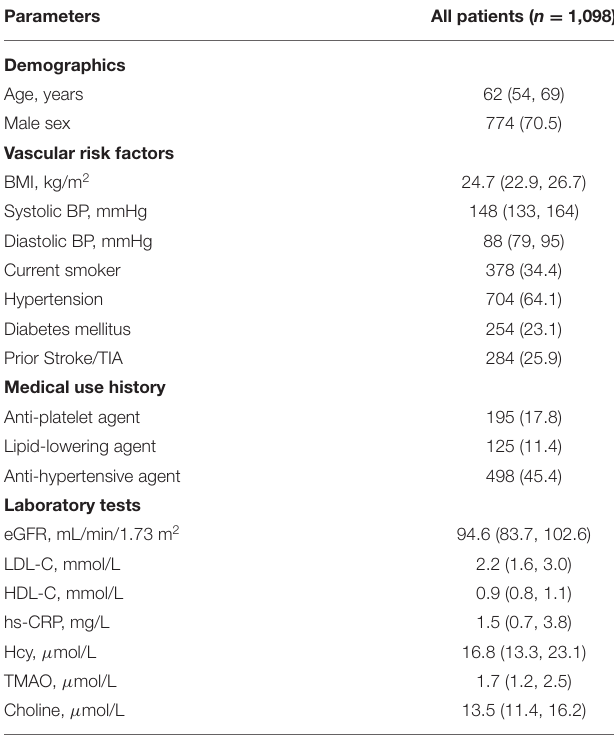
TABLE 1 | Characteristics of the study population.